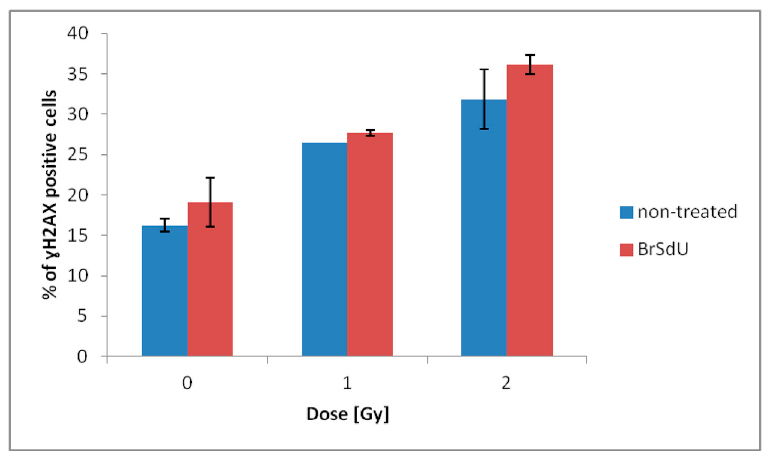
Figure 8. Flow cytometric analysis of H2A.X phosphorylation. γ H2A.X was measured 1 h after irradiation. Results are shown as the mean ± standard deviation of at least two independent flow cytometry experiments.